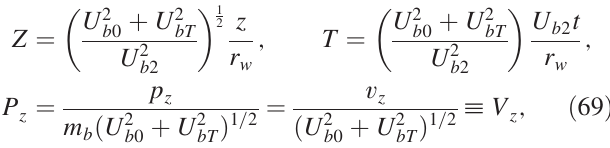
FIG. 10. Plots of (a) V ð η Þ versus η ; and (b) η ð Z 0 Þ versus Z 0 , obtained from Eqs. (56) and (62) for M 2 ¼ 1 . 2 , ϵ corresponding to soliton amplitudes η þ ¼ 0 . 297 . Shown in (c) is a self-consistent phase-space plot for the waterbag distribution [Eq. (31)] for the choice of system parameters in Fig.